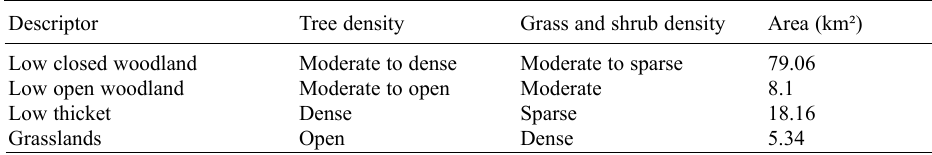
Characteristics of the four structural habitat type